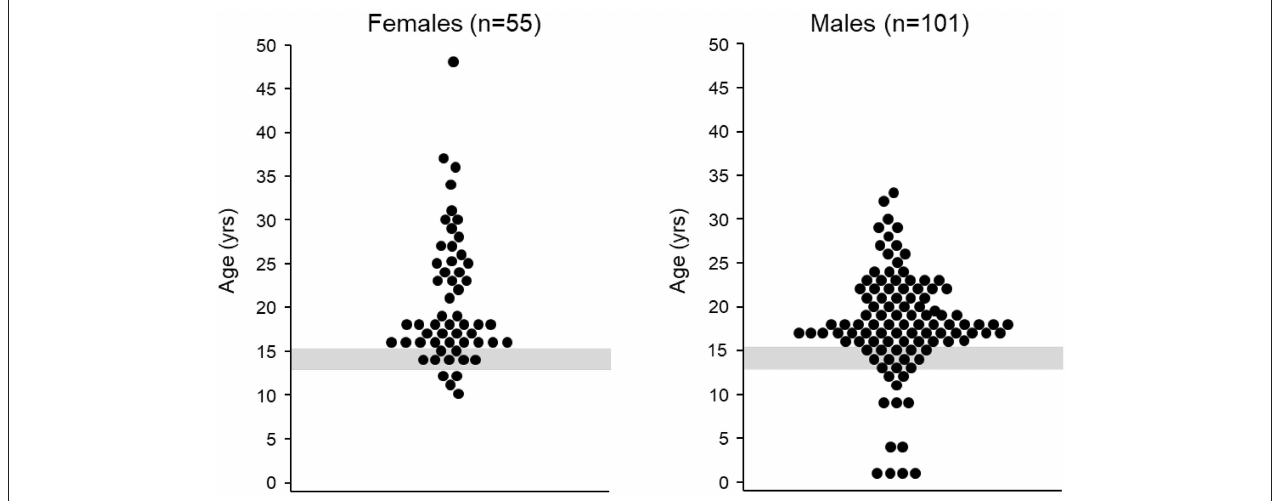
FIGURE 1 | Age at diagnosis. Left age at CHH/KS diagnosis for female patients ( n = 55), median age at diagnosis = 18 years (mean: 21 ± 7 years). The gray shaded region depicts the mean age of menarche plus two standard deviations ( 15). Figure adapted from Dzemaili et al. (16). Right age at CHH/KS diagnosis for male patients ( n = 101), median age at diagnosis = 18 years (mean: 18 ± 6 years, The gray shaded region depicts mean age of genital stage 3 plus two standard deviations ( 17). Figure adapted from Dwyer et al.